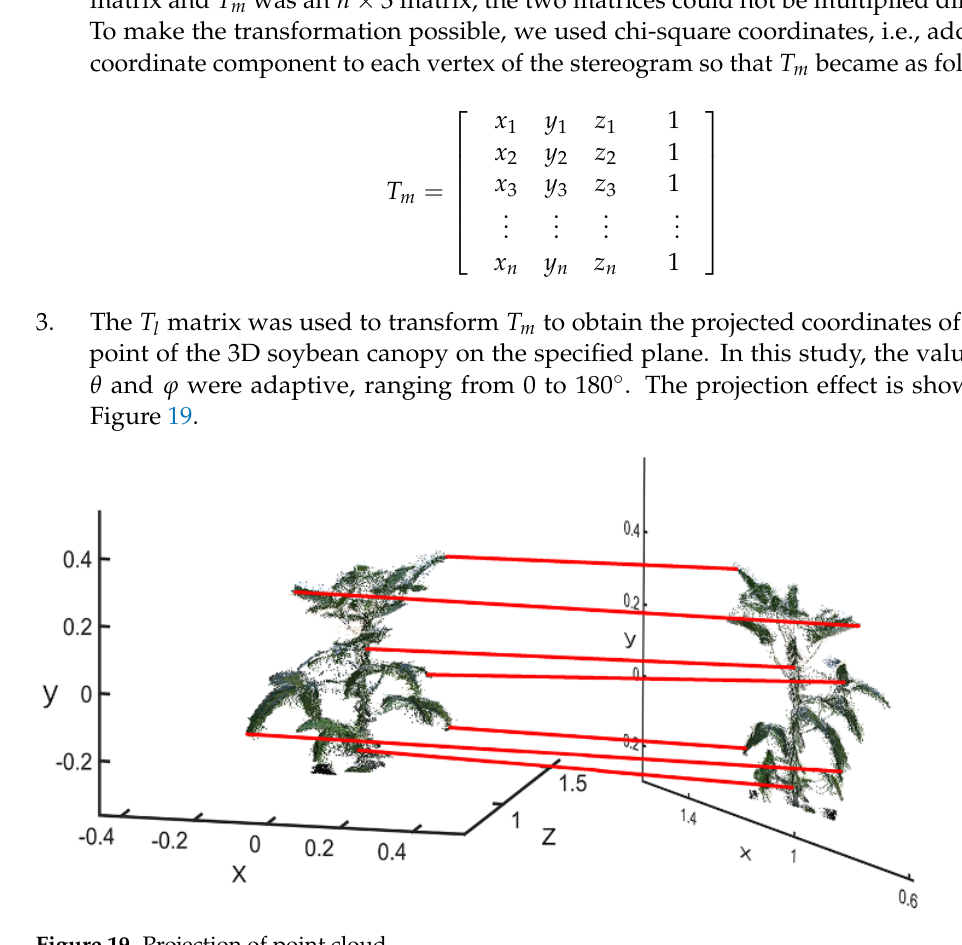
Figure 19. Projection of point